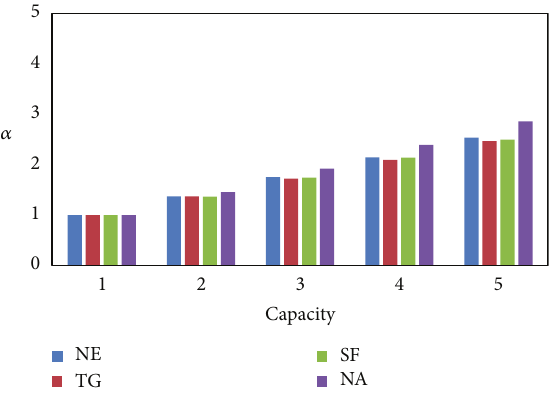
Figure 6: Average number of POIs versus